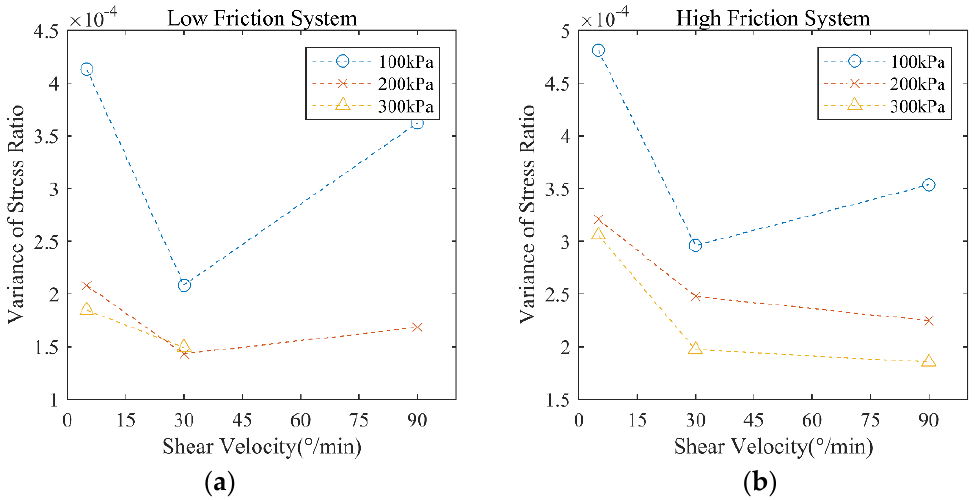
Figure 6. Relationship between shear velocity and the variance of stress ratio under different normal